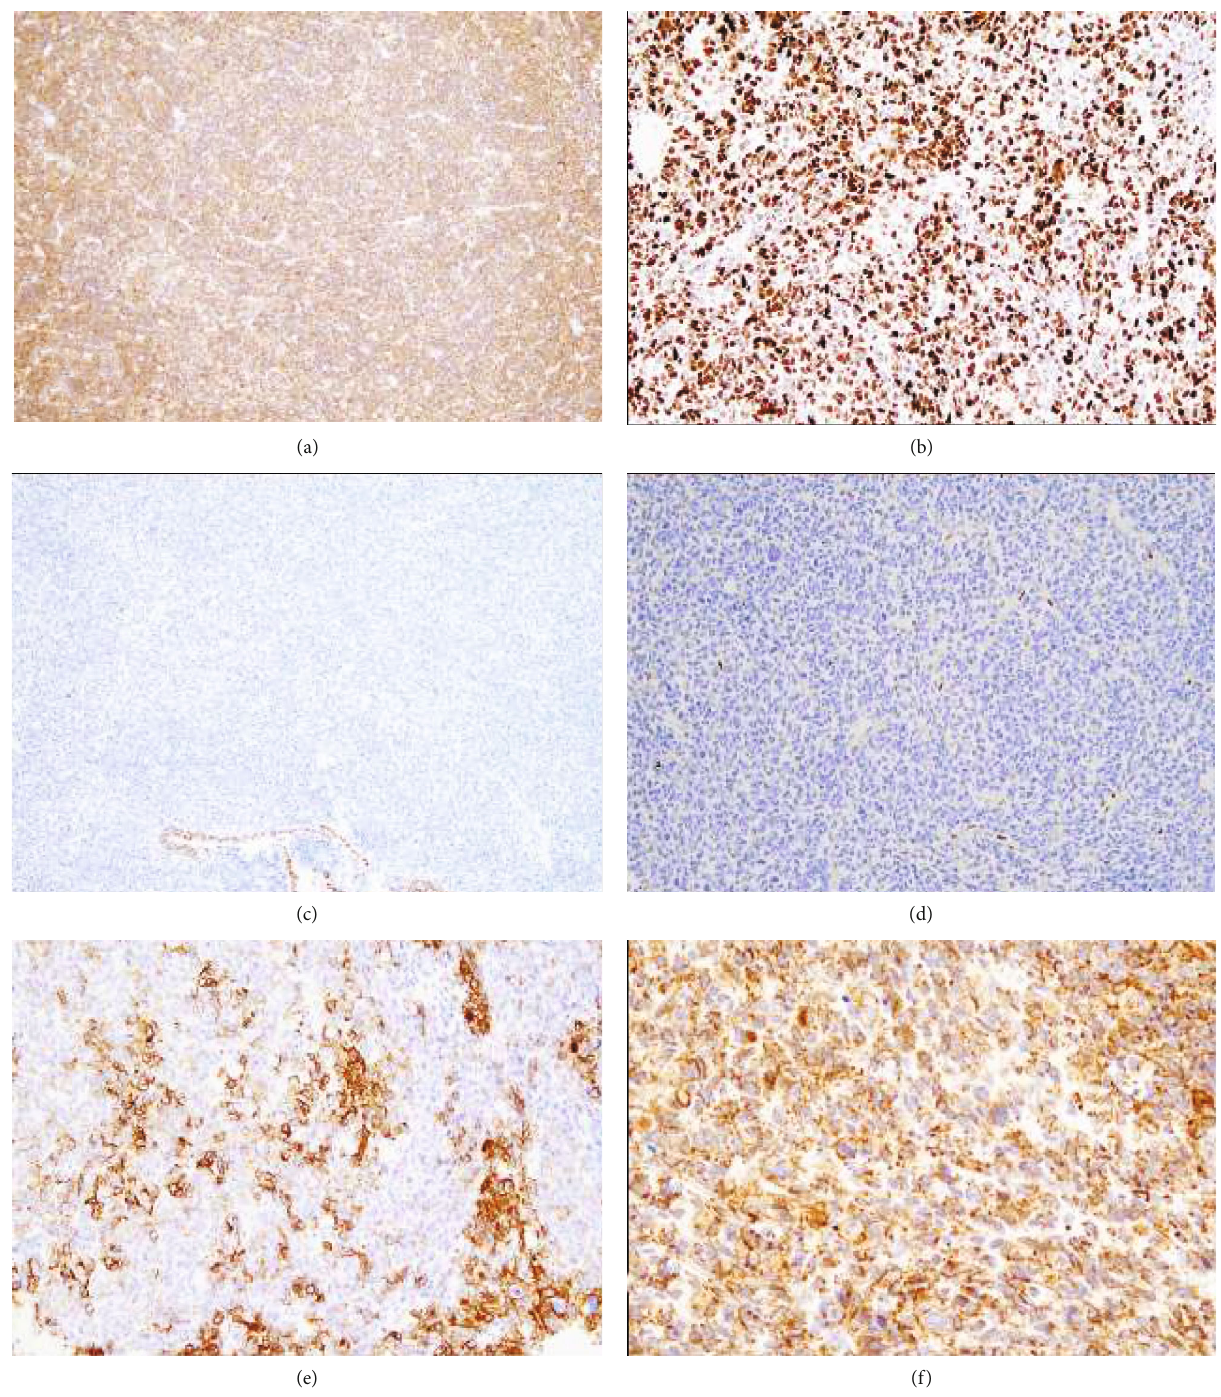
Figure 4: Immunohistochemistry image of the sertoliform endometrioid carcinoma component. (a) p16 showed di ff use staining in the solid area of the sertoliform element. (b) p53 also showed di ff use staining in the solid area. (c) PAX8 was negative. (d) ER was also negative. (e) CD56 was positive. (f) Membranous staining of β -catenin was diminished, while the cytoplasm was positively stained. (A, C: × 10, B, D, E: × 20, F: ×